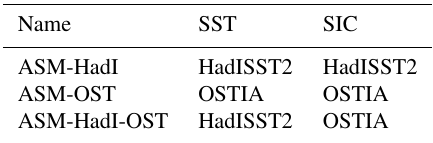
Table 3. Sensitivity experiments to inform the choice of SST and SIC observation data